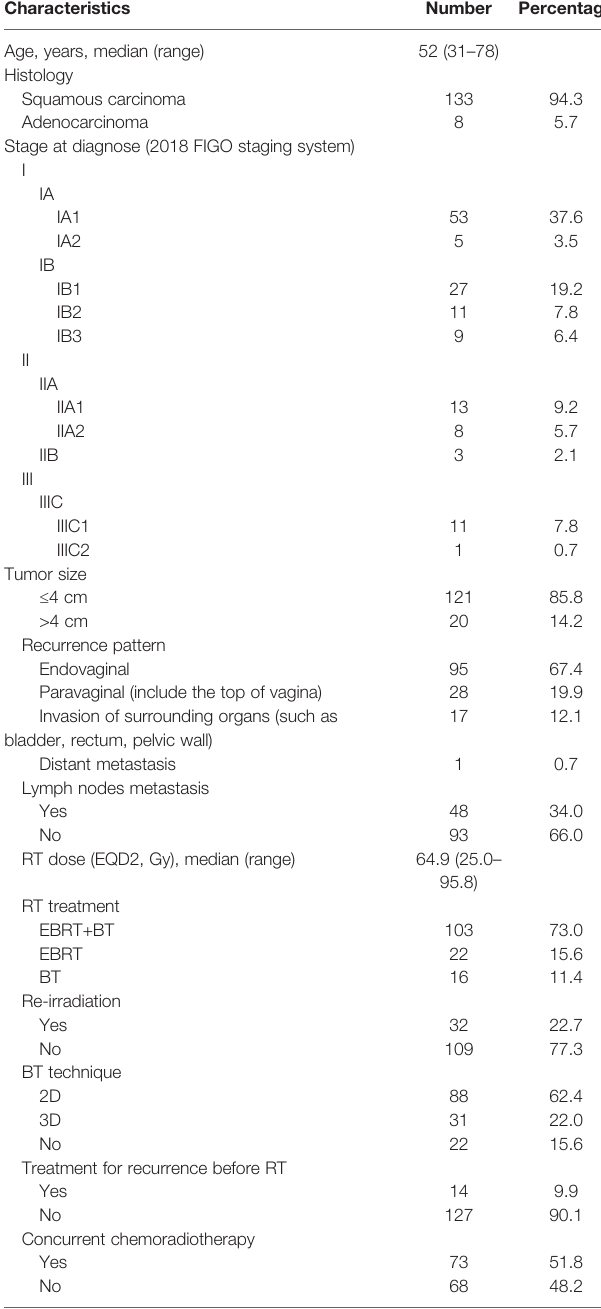
FIGO, International Federation of Gynecology and Obstetrics; RT, radiotherapy; EBRT, externalbeam radiotherapy;BT,brachytherapy; EQD2, equivalentdoseof 2 Gyper